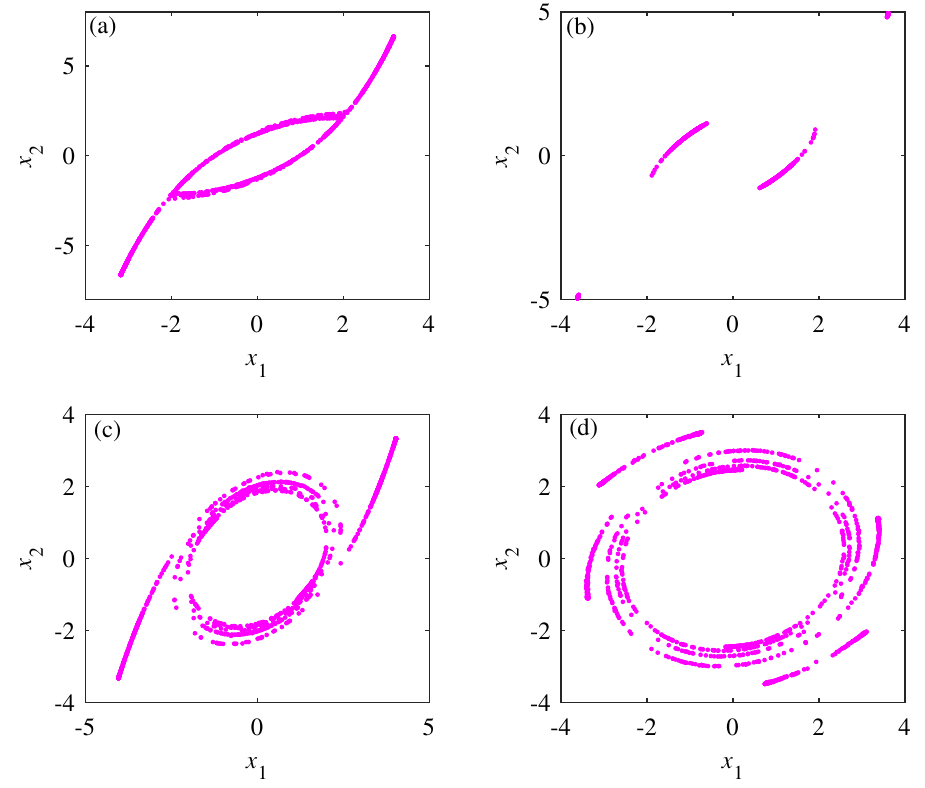
a k 4.5 . ( b ) ( 3 ) = 2 and = = a k 4.5 . ( d ) ( 3 ) = 4 and = =